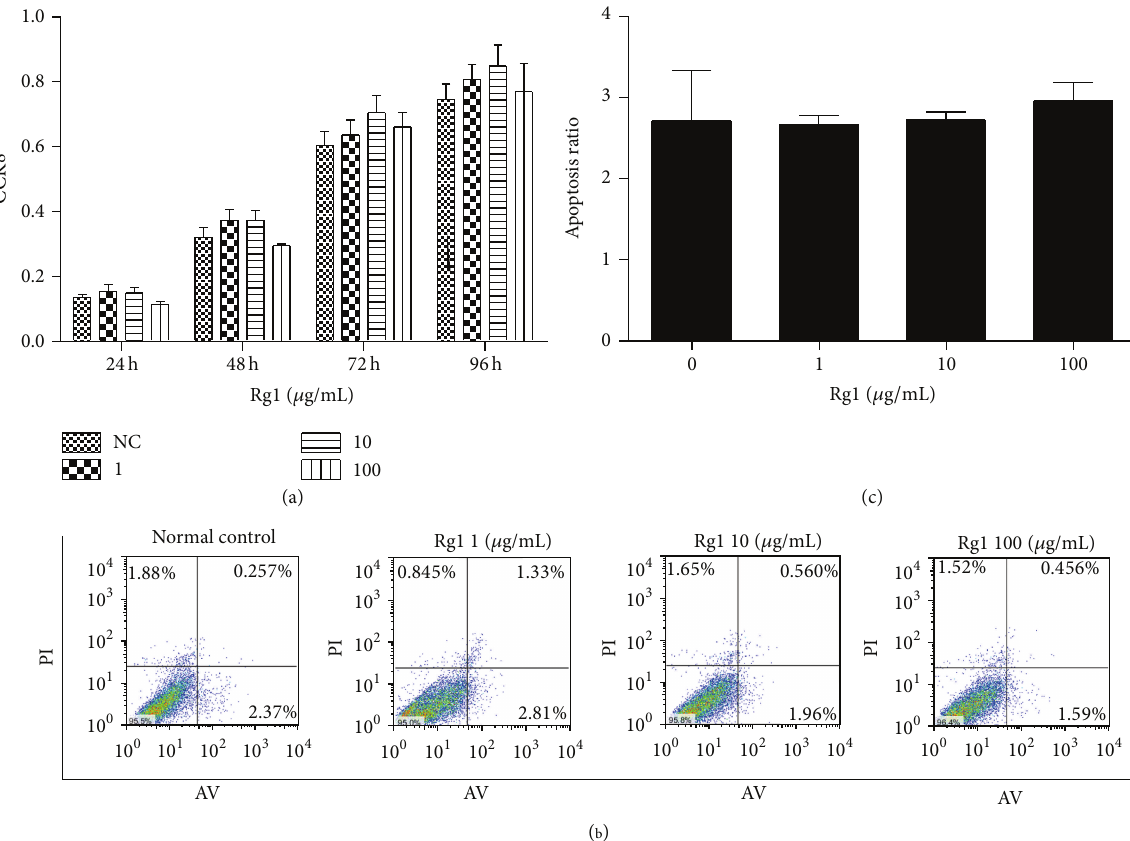
Figure 1: Effect of Rg1 on cell viability and apoptosis. (a) CCK8 assay was performed after incubation of RAW 264.7 cells (2 × 10 4 cells/mL) with Rg1 (1, 10, and 100 𝜇 g/mL) for 24, 48, 72, and 96 h in 96-well plates. (b) RAW 264.7 cells (1.0 × 10 5 cells/mL) were stimulated with or without the presence of Rg1 (1, 10, and 100 𝜇 g/mL) for 96 h in a 6cm culture plate. Cells were collected and stained with Annexin V and PI and then examined by flow cytometry. (c) FACS histogram of the percentage of early and late apoptosis cells. Values are expressed as the mean ± SD of triplicate experiments. All data are representative of three different